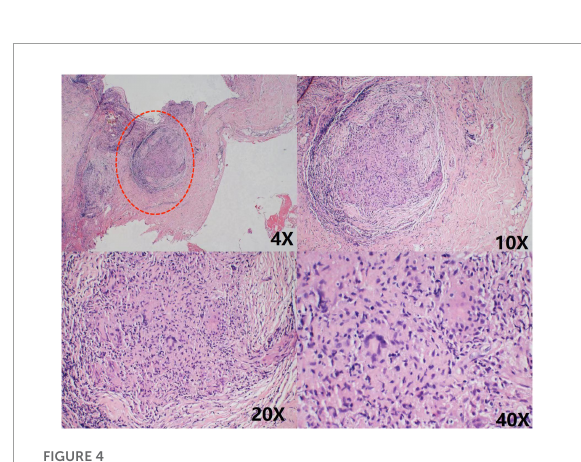
The patient was discharged with symptomatic treatment, but she was readmitted 1 month later with malaise, chest pain with hypothermia, and echocardiography indicated a small pericardial effusion. A single-center study involving 174 patients suggested that pericardial tissue biopsy is feasible for recurrent pericardial effusions to improve the likelihood of diagnosis in patients (17). Ultimately, this patient was diagnosed